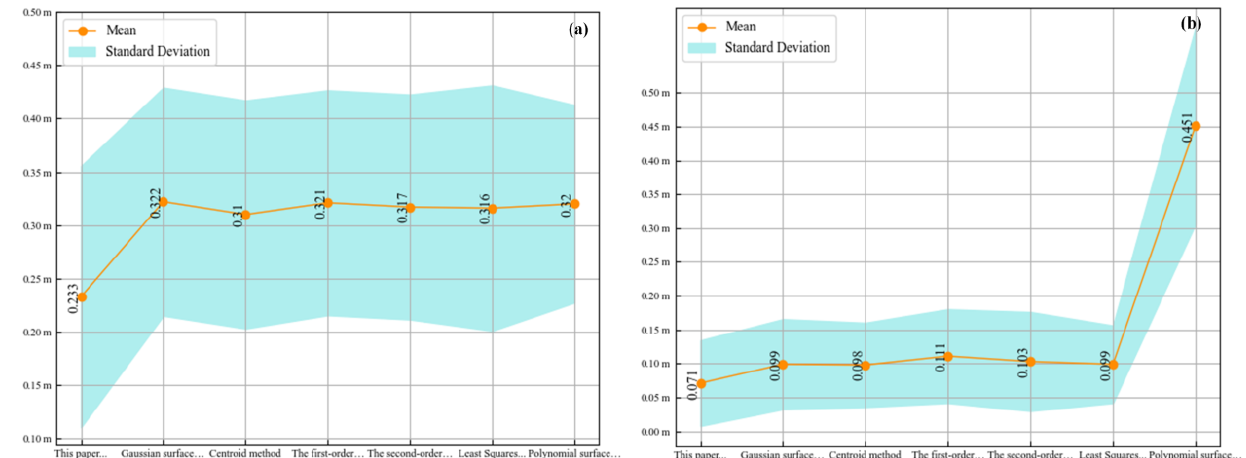
Figure 15. ( a ) Elevation accuracy verification of laser footprints for Beam 1 in 2021 positioned us- ing different methods; ( b ) elevation accuracy verification of laser footprints for Beam 2 positioned using different methods.